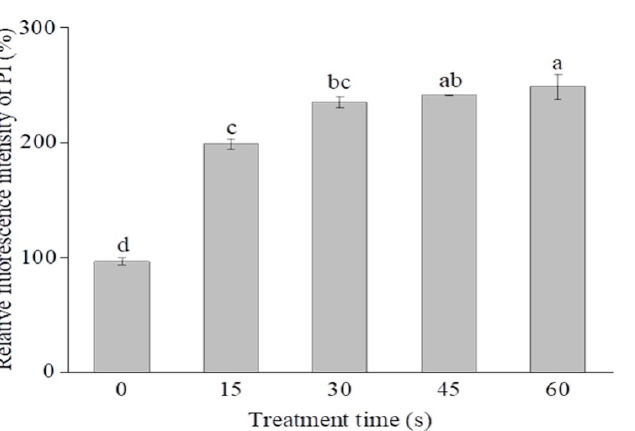
Figure 4. Changes in the membrane permeability of P. deceptionensis CM2 cells after SAEW treatment. Values marked with different letters are significantly different at p <0.05.